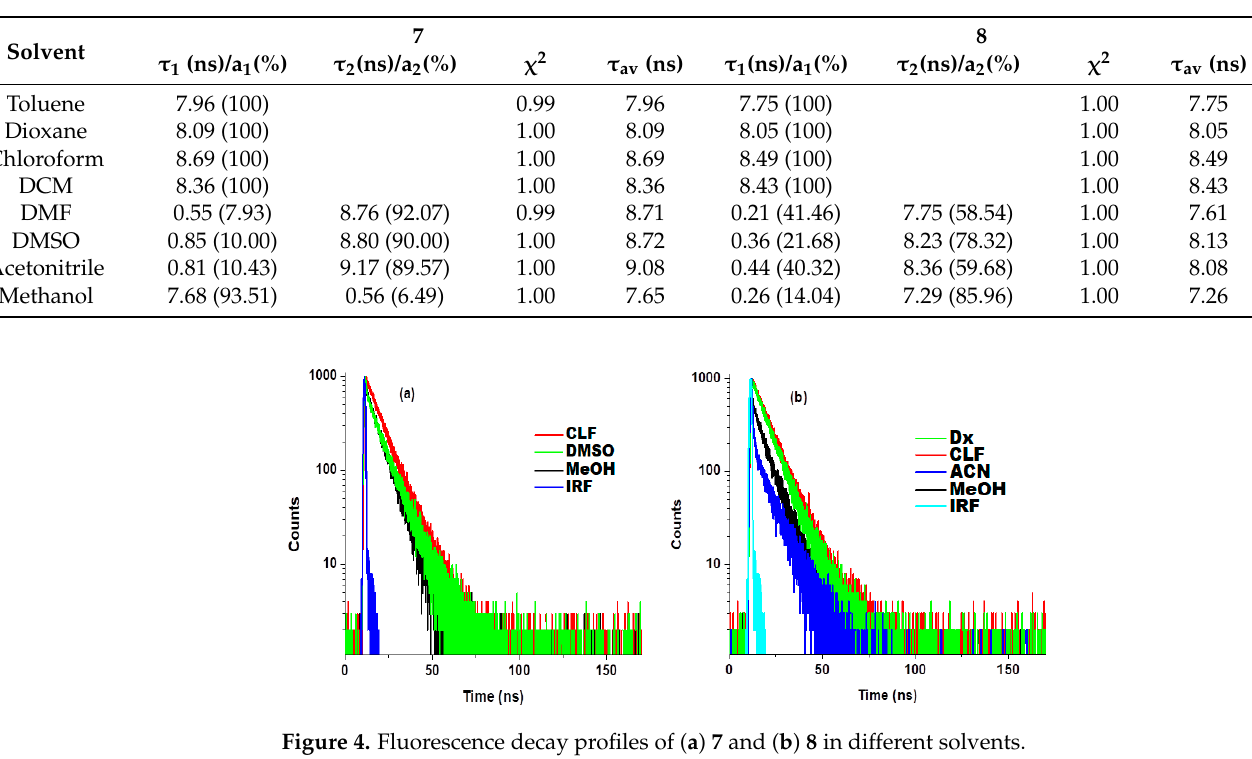
Table 3. Fluorescence lifetimes of piperidine-naphthalimides in different solvents.